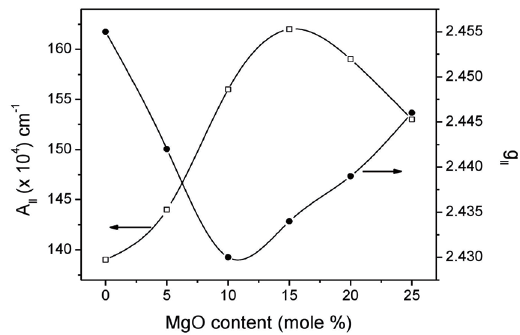
Figure 2: Variation of g|| and A|| with MgO content in the present study.